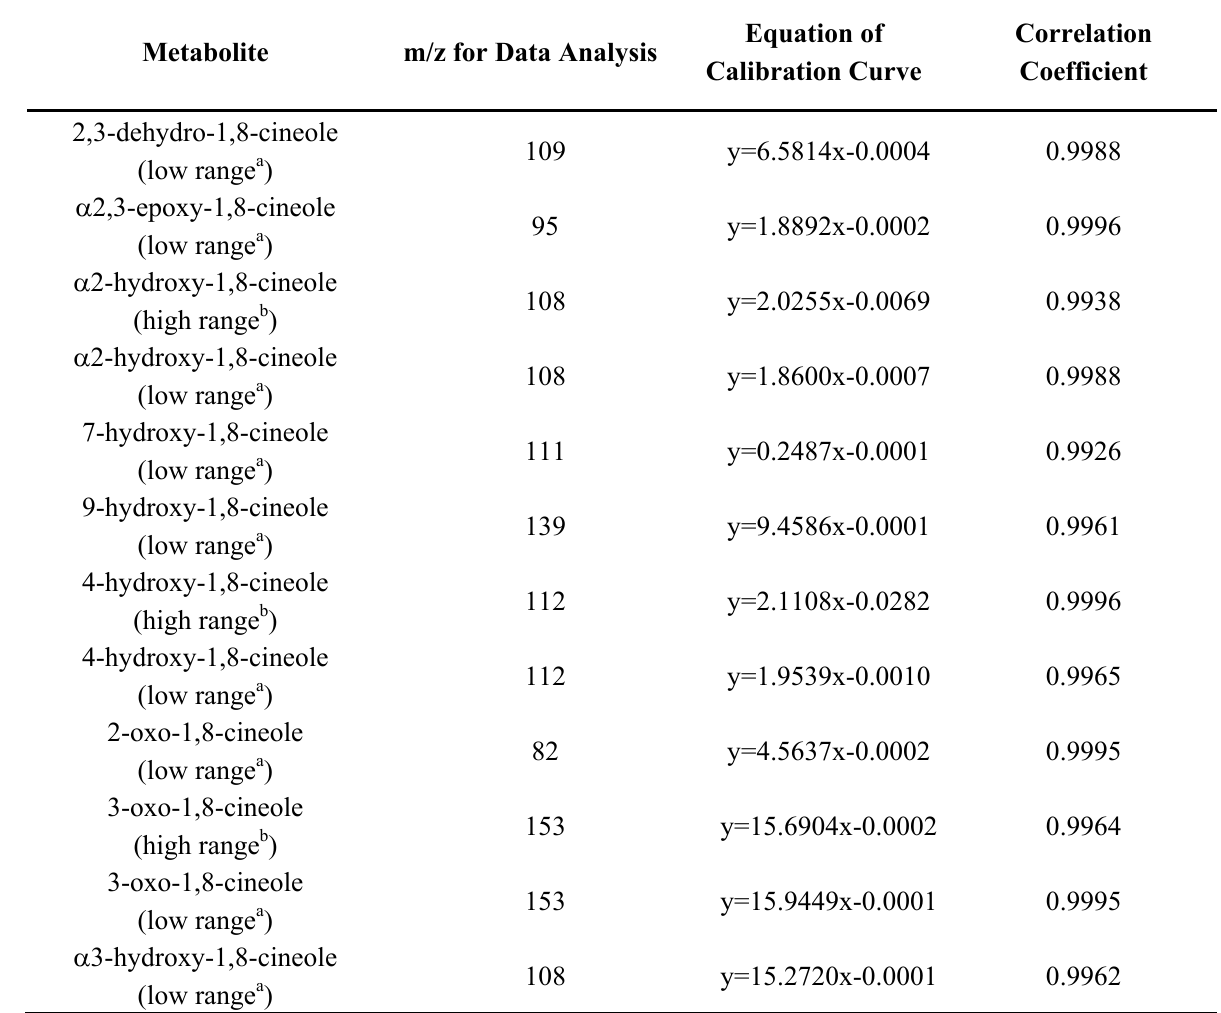
Table 4. Calibration curves used for quantification of metabolites of 1,8-cineole.